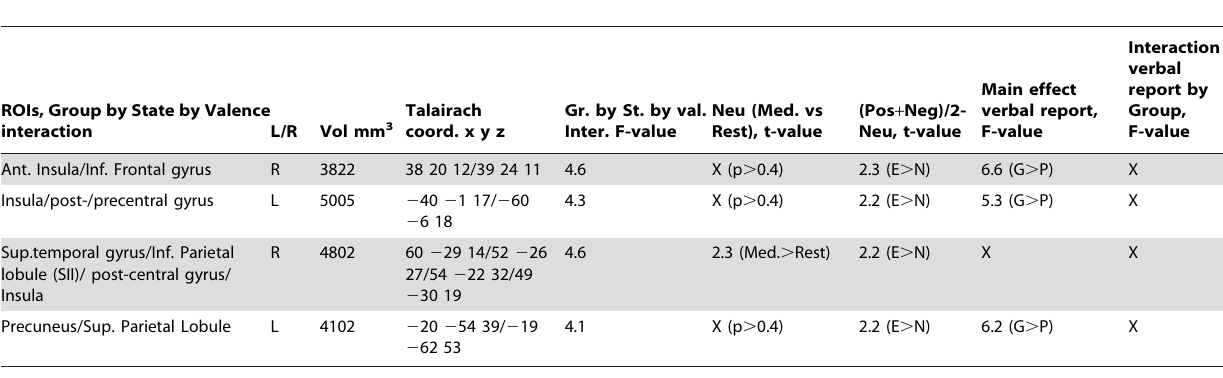
for experts than novices (group by state interaction, ANOVA, F(1,15)= 5.2, p , 0.05). The pupil diameter increase during meditation vs. rest positively correlated with the larger increase in anterior insula (AI) in responses to all sounds in meditation vs. Table 1. Group by State by Valence interaction.